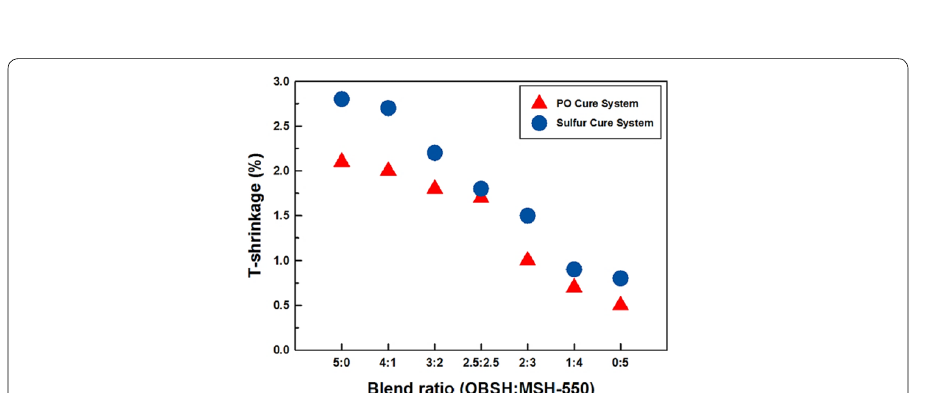
Fig. 7 Thermal shrinkage of bio‑EPDM foam depending on the mixing ratio of blowing